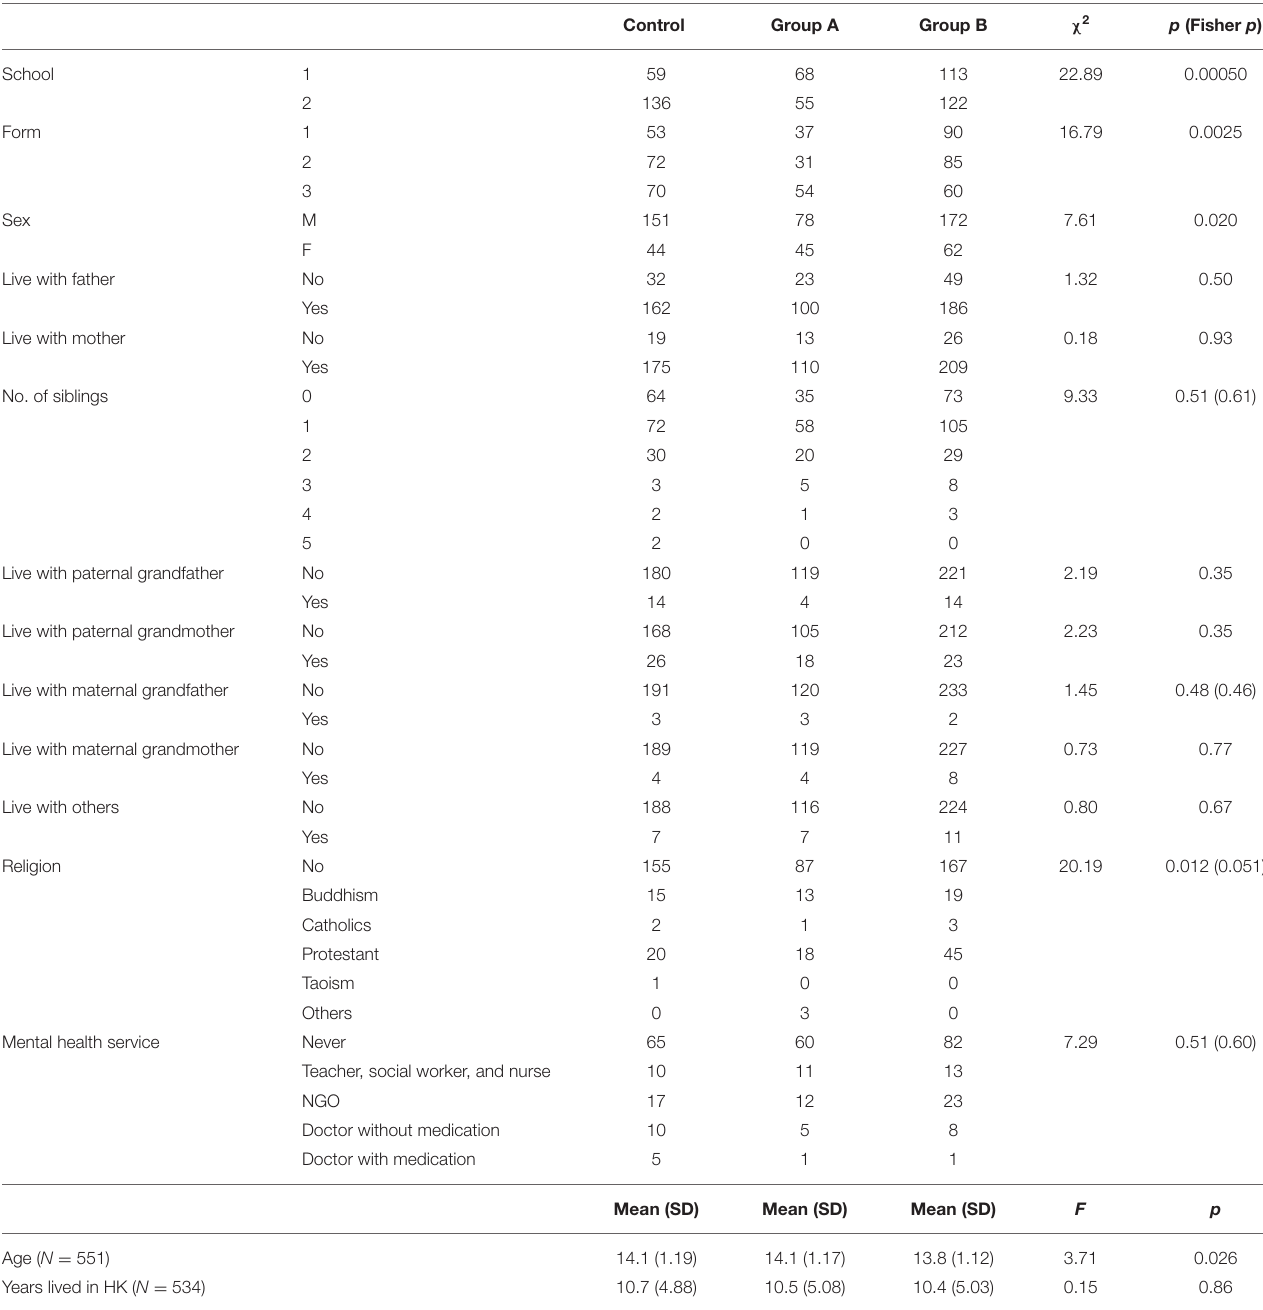
TABLE 1 | Demographic